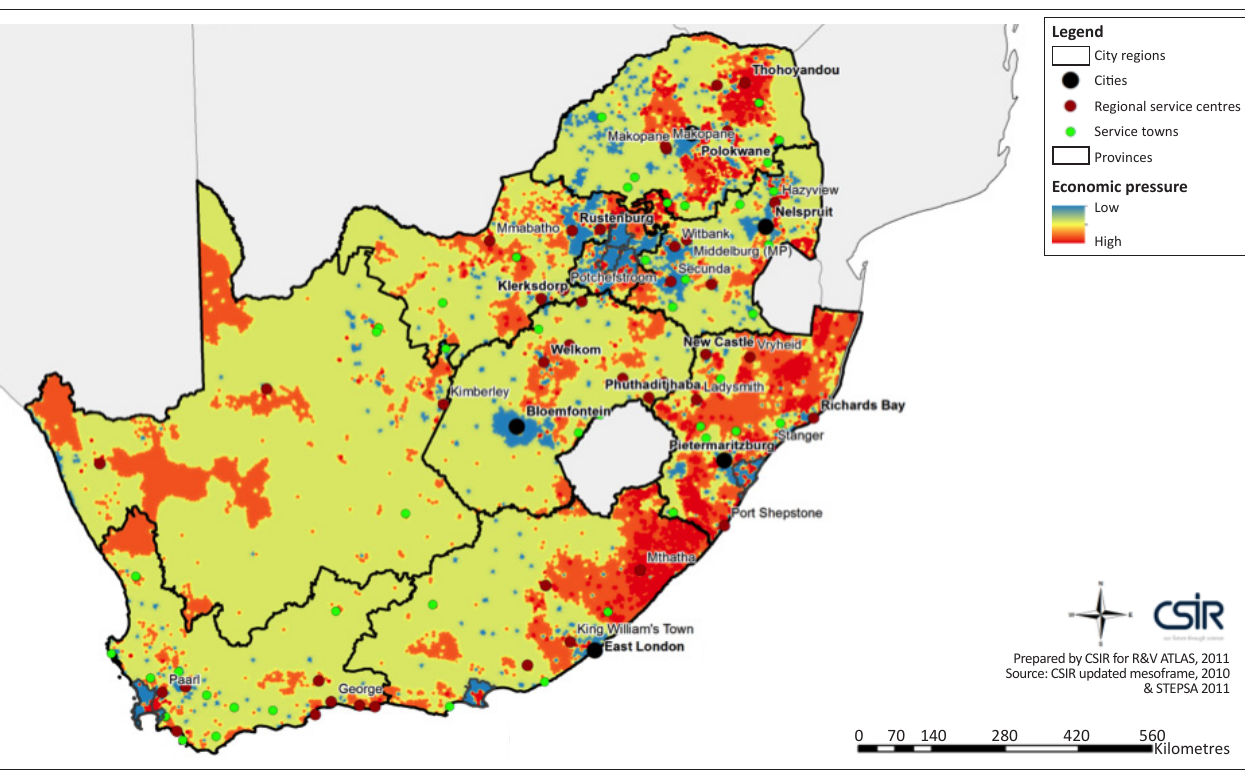
FIGURE 1: South Africa’s social pressure areas due to high population densities and population growth (the red arrows are an indication and/or proxy for the internal migration patterns and/or movement between 1999 and 2009).